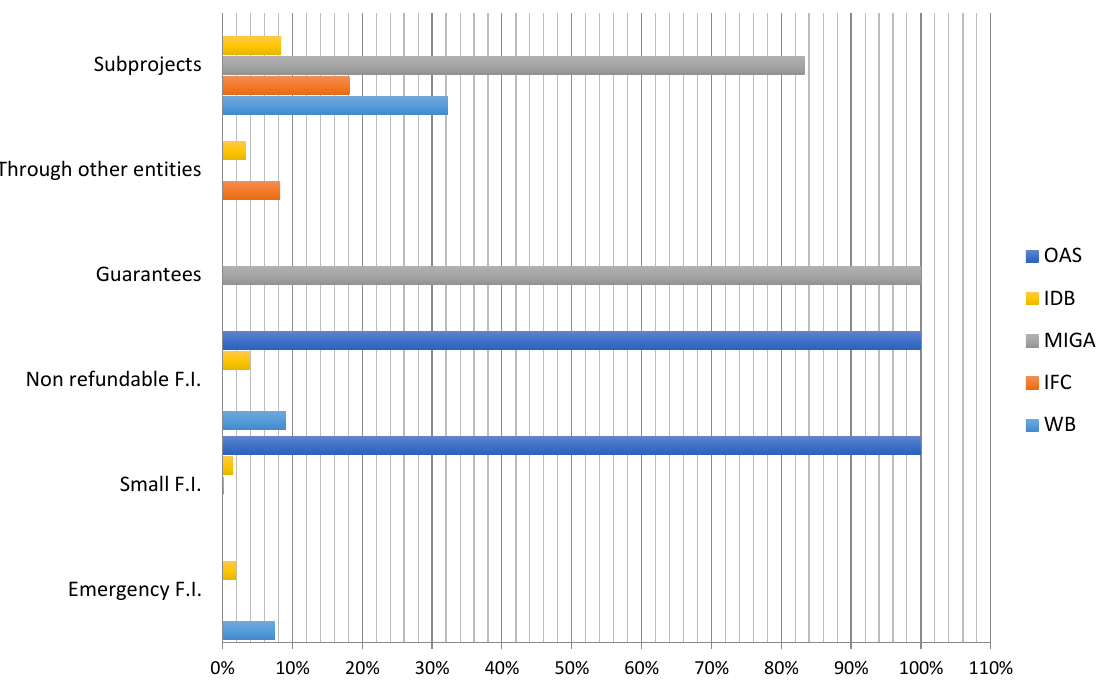
Figure 5. Indicators D6, D7, D8, D9, D10 and D11, financial instruments used by the IFIs for the funding of tourism, by